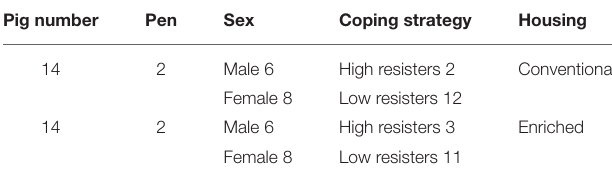
TABLE 1 | Dataset details: experimental setup. Pig number Pen Sex Coping